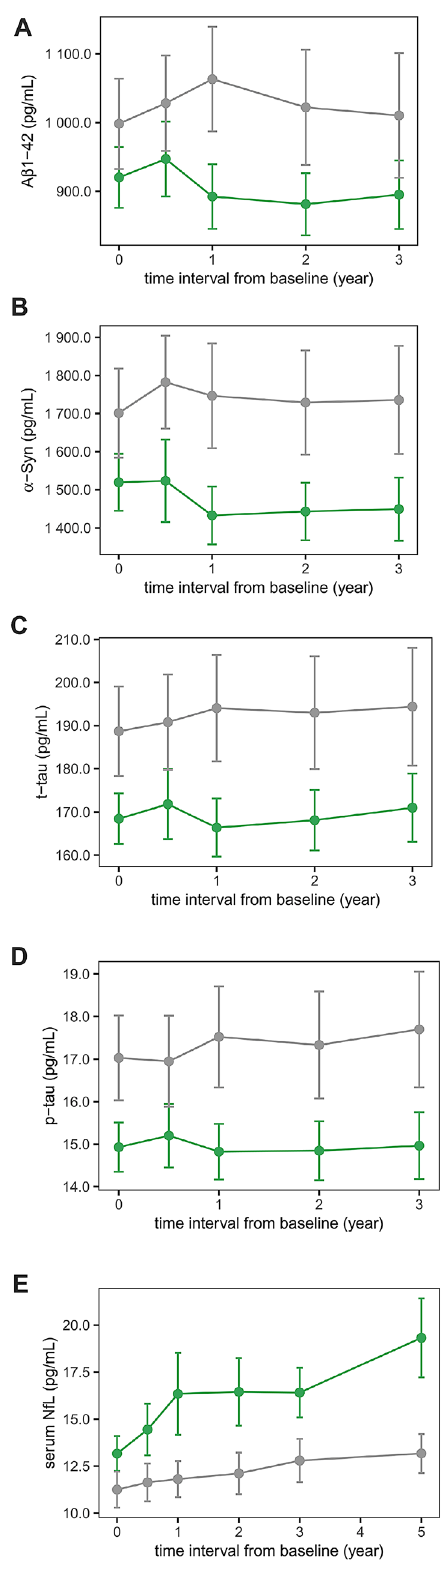
Figure 1. Measured biomarker levels in the PPMI study. Dots represent mean values of biomarkers at each follow-up visit. Error-bars denote 95% confidence interval (green lines and dots = PD patients; gray lines and dots = controls). Figures are illustrated using ggplot2 and patchwork packages in R software. Aβ 1-42 amyloid-β 1-42 ; α-syn α-synuclein; t-tau total tau; p-tau phosphorylated tau; NfL neurofilament light